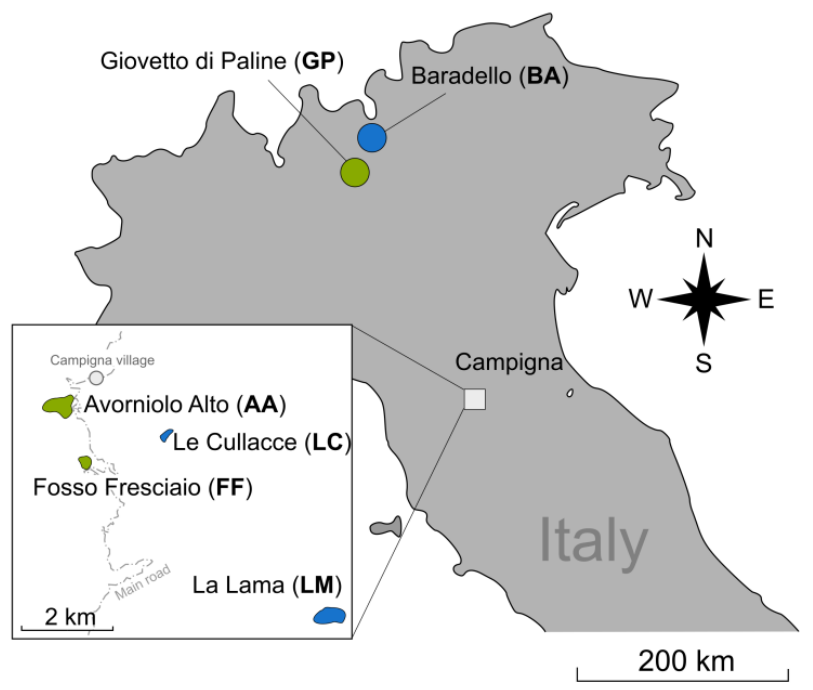
Figure 1. Map of the two original Alpine and the four imported populations of Formica paralugubris . The same color denotes the same origin.